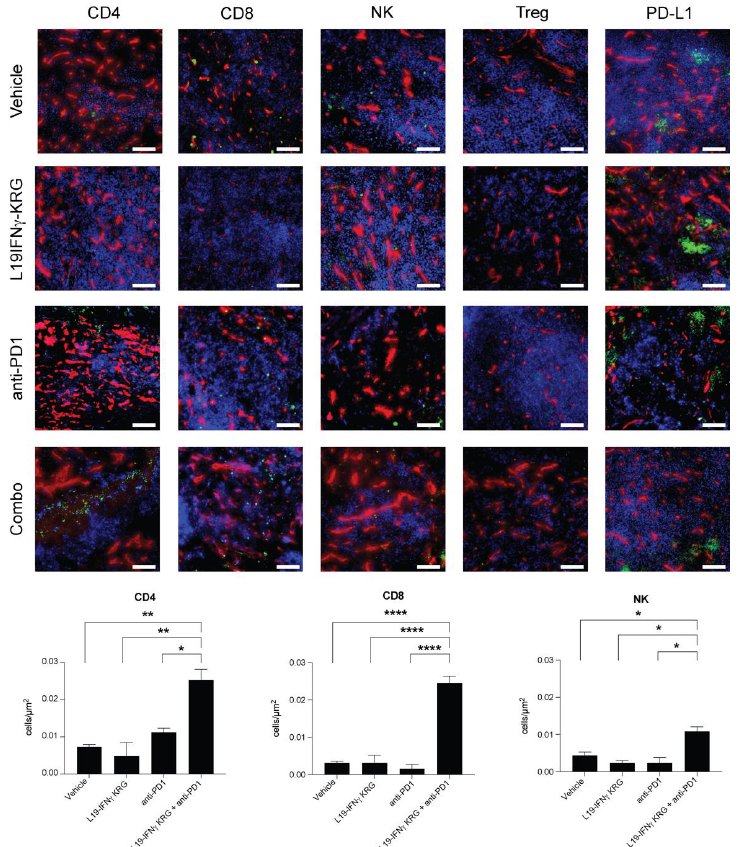
Figure 7. Microscopic analysis and quantification of tumor-infiltrating cells in WEHI-164 tumor sections. Ex-vivo immunofluorescence analysis on WEHI-164 sarcoma 24 h after the third injection of Vehicle, anti-PD-1 and L19-mIFN γ KRG alone or in combination with 200 μg of anti -PD-1. Marker specific for, CD4 + Tcells (CD4), CD8 + Tcells (CD8), NK cells (NCR1), Tregs (Foxp3), and PD-L1 were used (green). Blood vessels were stained with an anti-CD31 antibody (red). Magnification:10×; scale bars = 100 μm. The panel below shows the quantification of CD4+, CD8+ and NK cells through imaging software. Three distinct slide sections were used for each group and cell subset. Results are expressed as number of cells and normalized on the section area (±SEM). (*: p < 0.05, **: p < 0.01, ****: p < 0.0001).